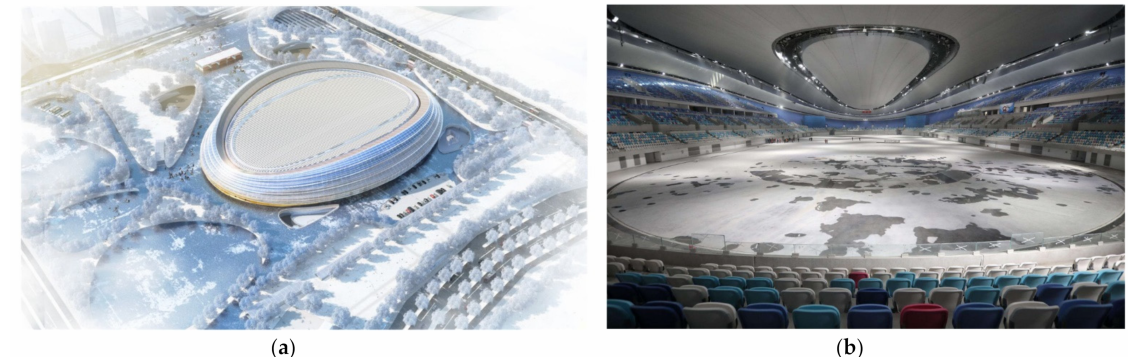
Figure 9. The National Speed Skating Oval of Beijing 2022 Winter Olympics. ( a ) overview; ( b ) indoor